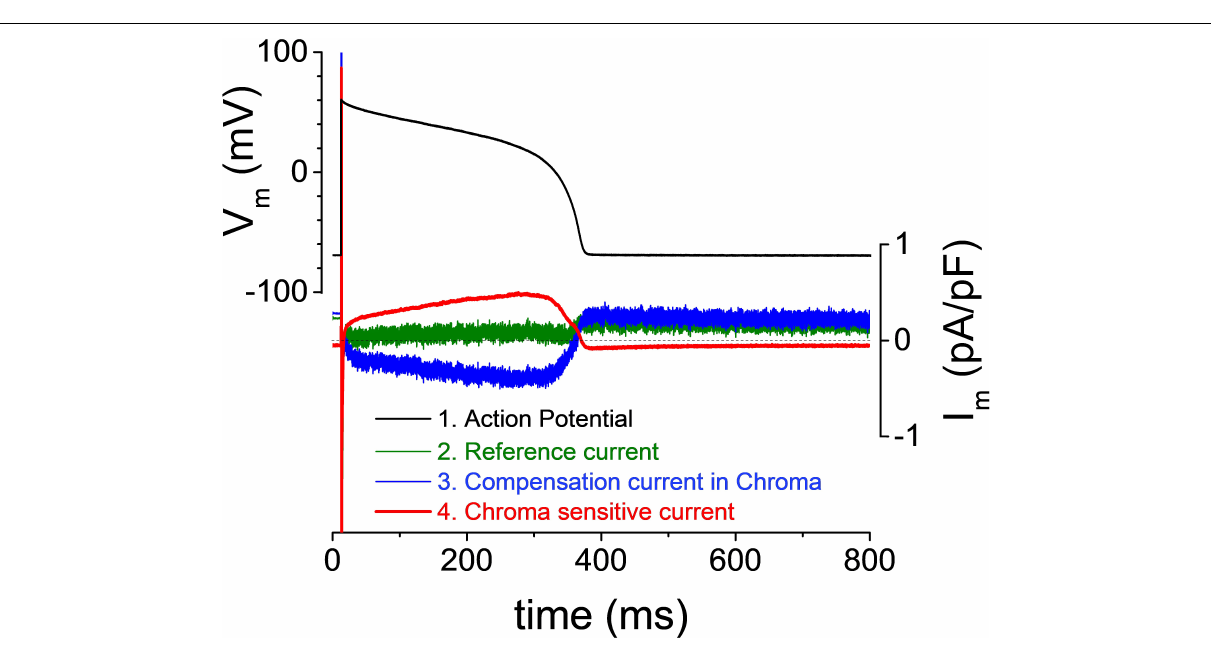
FIGURE 2 | Self-action potential clamp recording of an ion current. The cell’s action potential (depicted in black) is used as command voltage. The reference current (depicted in green) is recorded immediately after steady state was achieved. After the application of Chroma (Chromanol-293B), I Ks was blocked, and the compensation current (depicted in blue) was provided by the amplifier. The Chroma-sensitive current (depicted in red) was obtained by subtraction of the compensation current from the reference